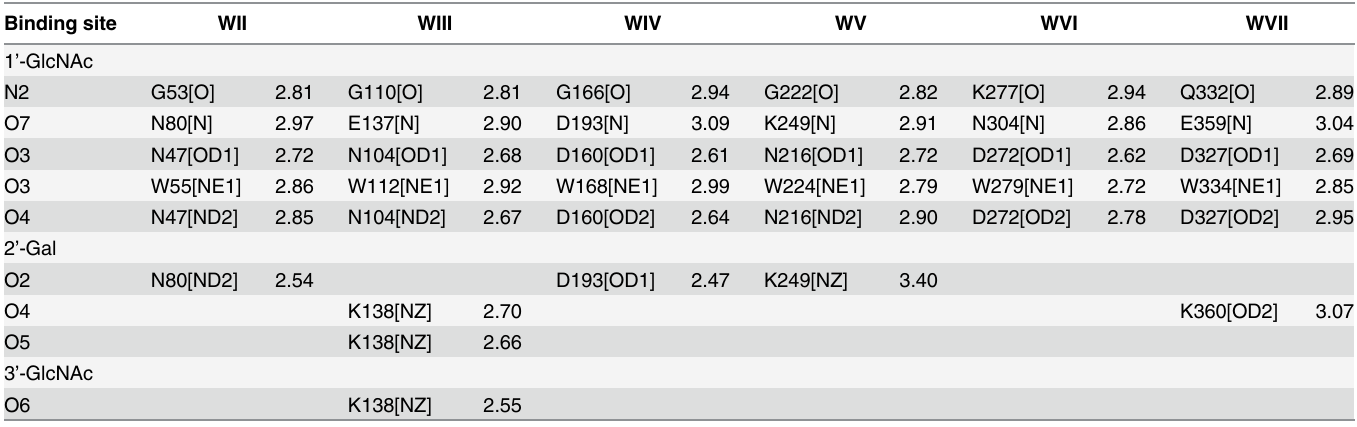
Table 3. Polar interactions (distances in Å ) between GlcNAc β 1-3Gal β 1-4GlcNAc and AAL2. Binding